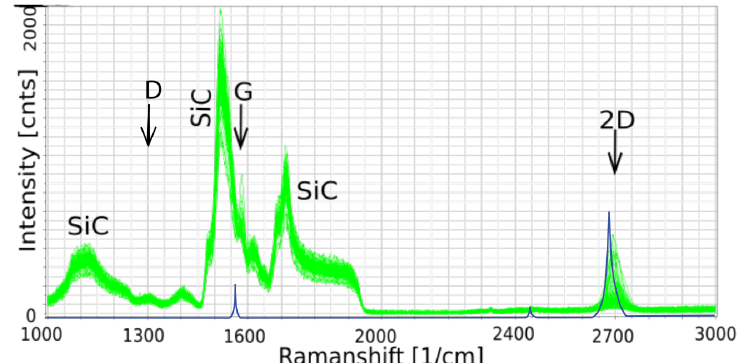
Figure 1. Measured Raman spectra of a characteristic sample with the signature of a 6H-SiC substrate (marked as SiC) with characteristic graphene peaks (marked as D, G and 2D). The green curves represent mapping spectra of 100 equally spaced points within the area of a typical Raman mapping (100 × 100 µ m 2 ). Each individual spectrum corresponds to graphene grown on the C-polar face of SiC. For comparison, the typical spectrum of a monolayer graphene without a signature of a SiC substrate beneath the layer is plotted in blue as a reference. These reference data were replotted from [1]. Table 1. List of all the samples, showing the information about the basic growth parameters as well as the most important results. The abbreviation ND means that there are no data available. For the samples where numbers are replaced by lines, there was either no signal detected or the condition 2D > G was untrue. Samples (Numbered w.r.t. Growth Experiments)